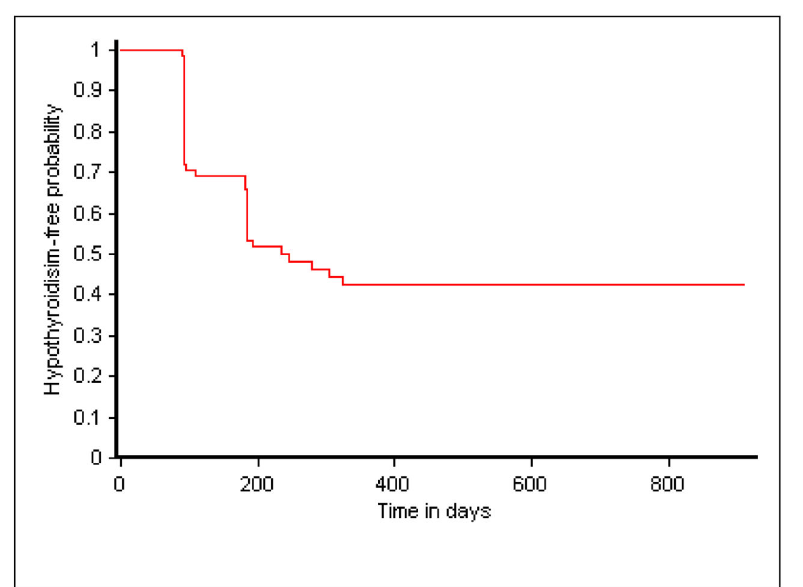
Figure 2. Time-to-Hypothyroidism following initiation of MDR-TB treatment using Kaplan-Meier analysis.